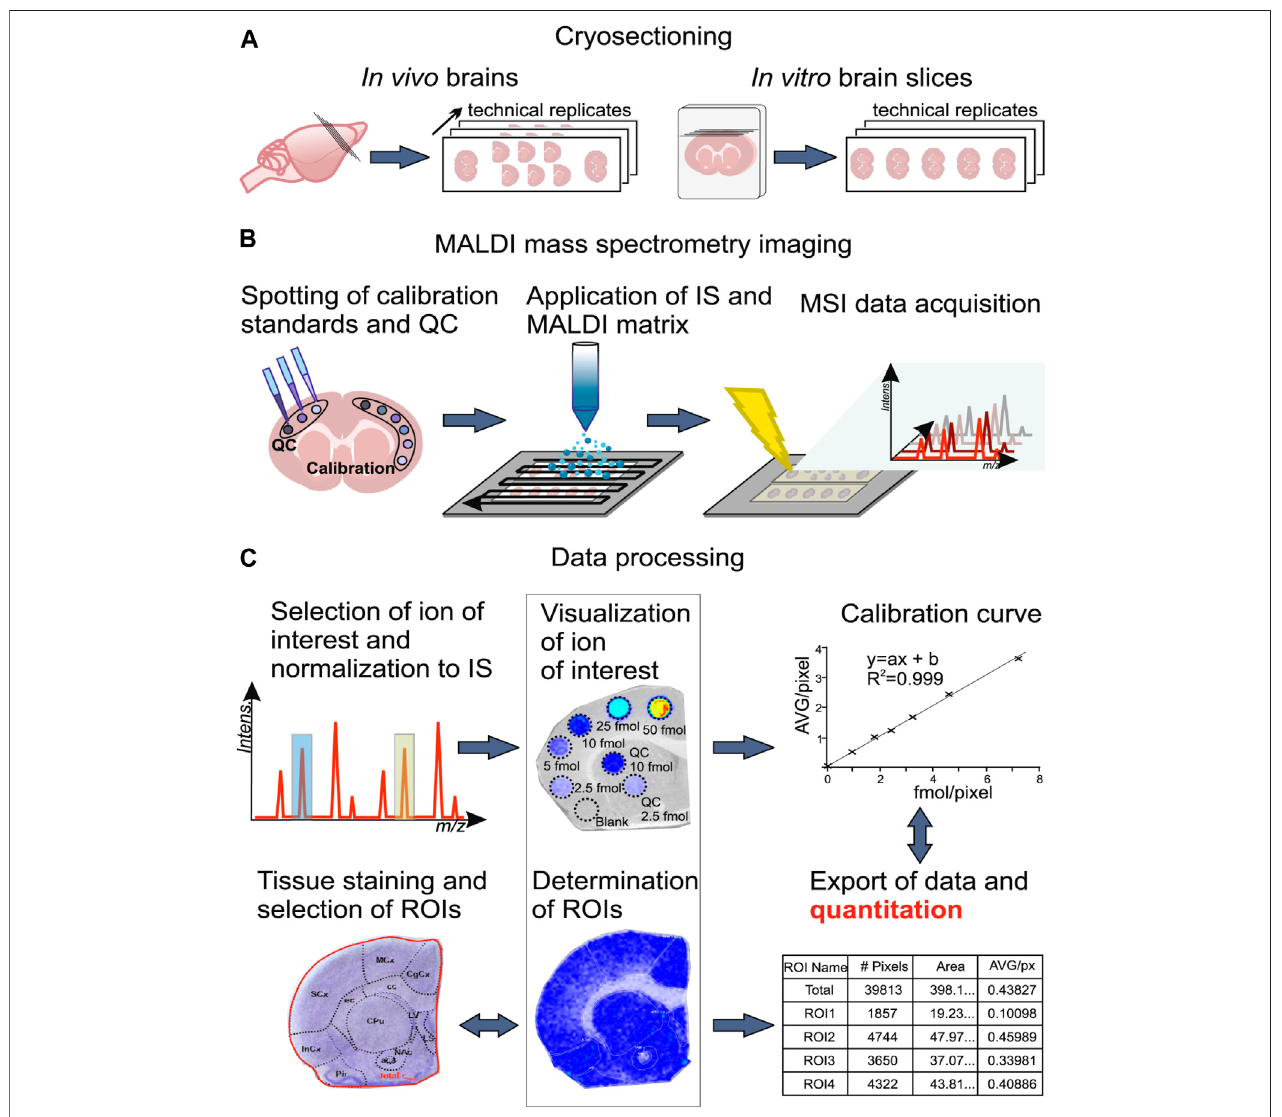
FIGURE 5 | Illustration of the work fl ow for assessing total brain drug concentrations using qMSI-uD (Luptakova et al., 2021).